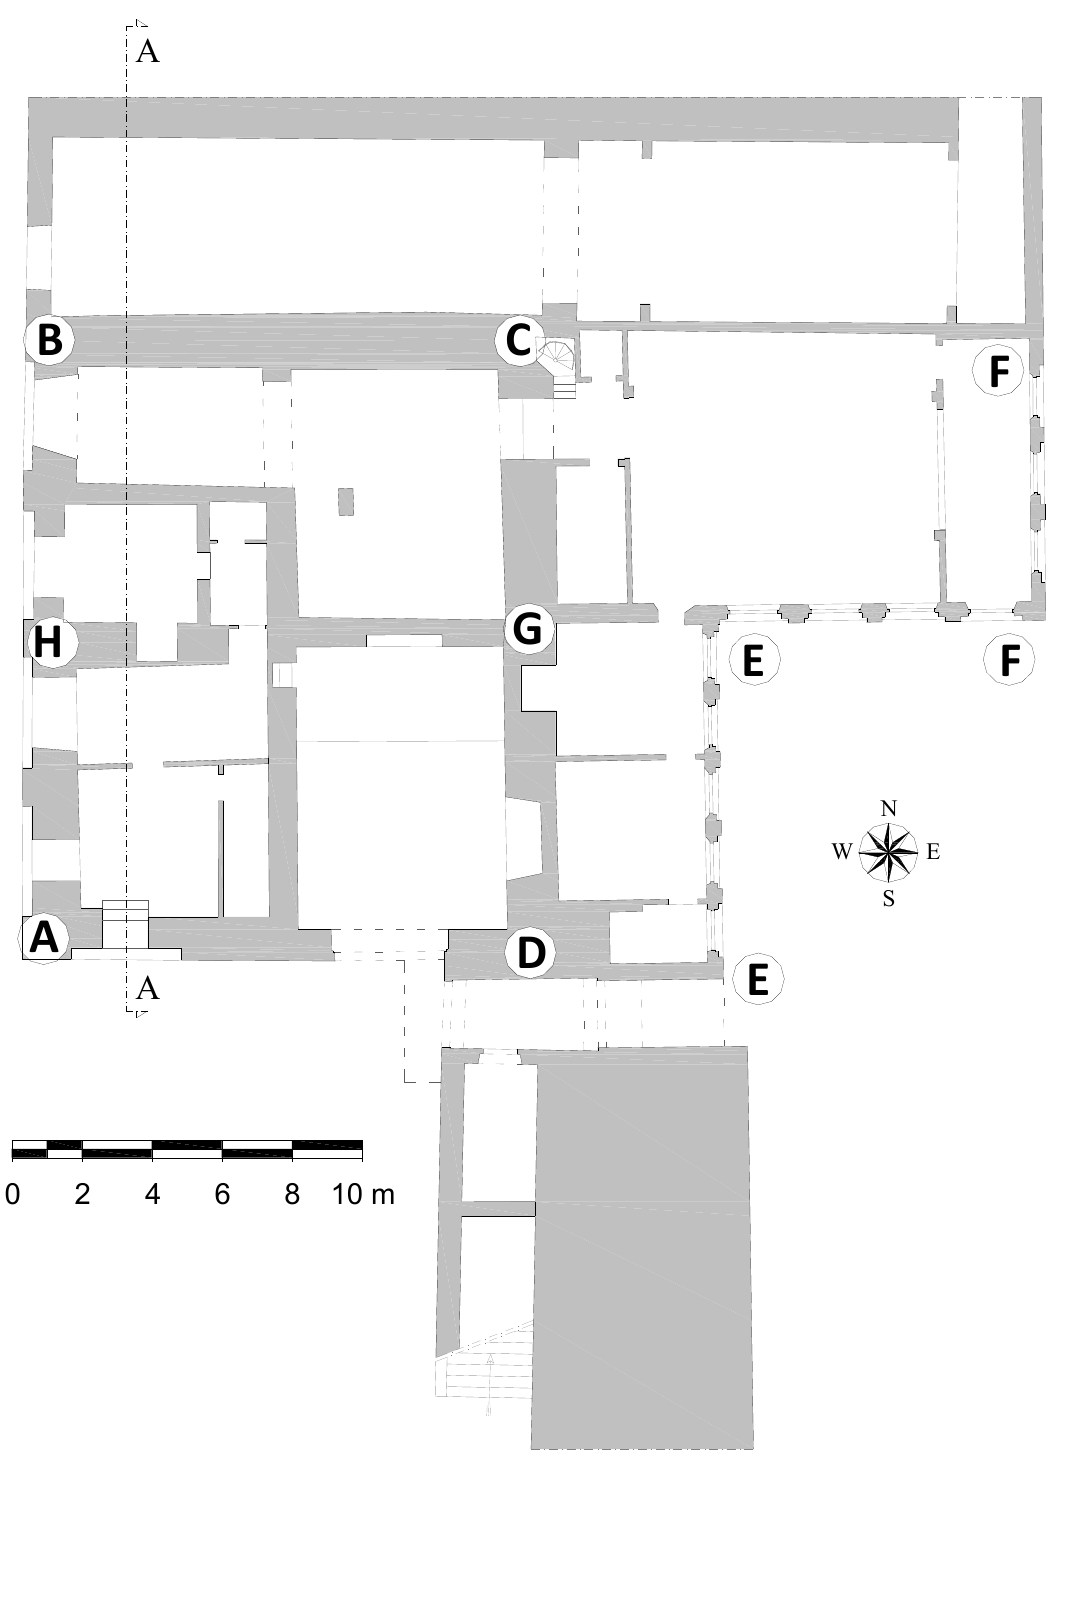
Figure 2. Plan layout of the ground floor (ABCD is the original medieval square nucleus; EE-FF is a twentieth century